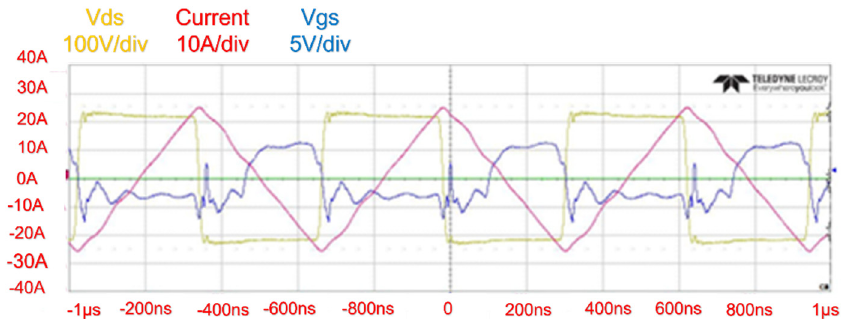
Figure 7. Test on the RLC configuration.